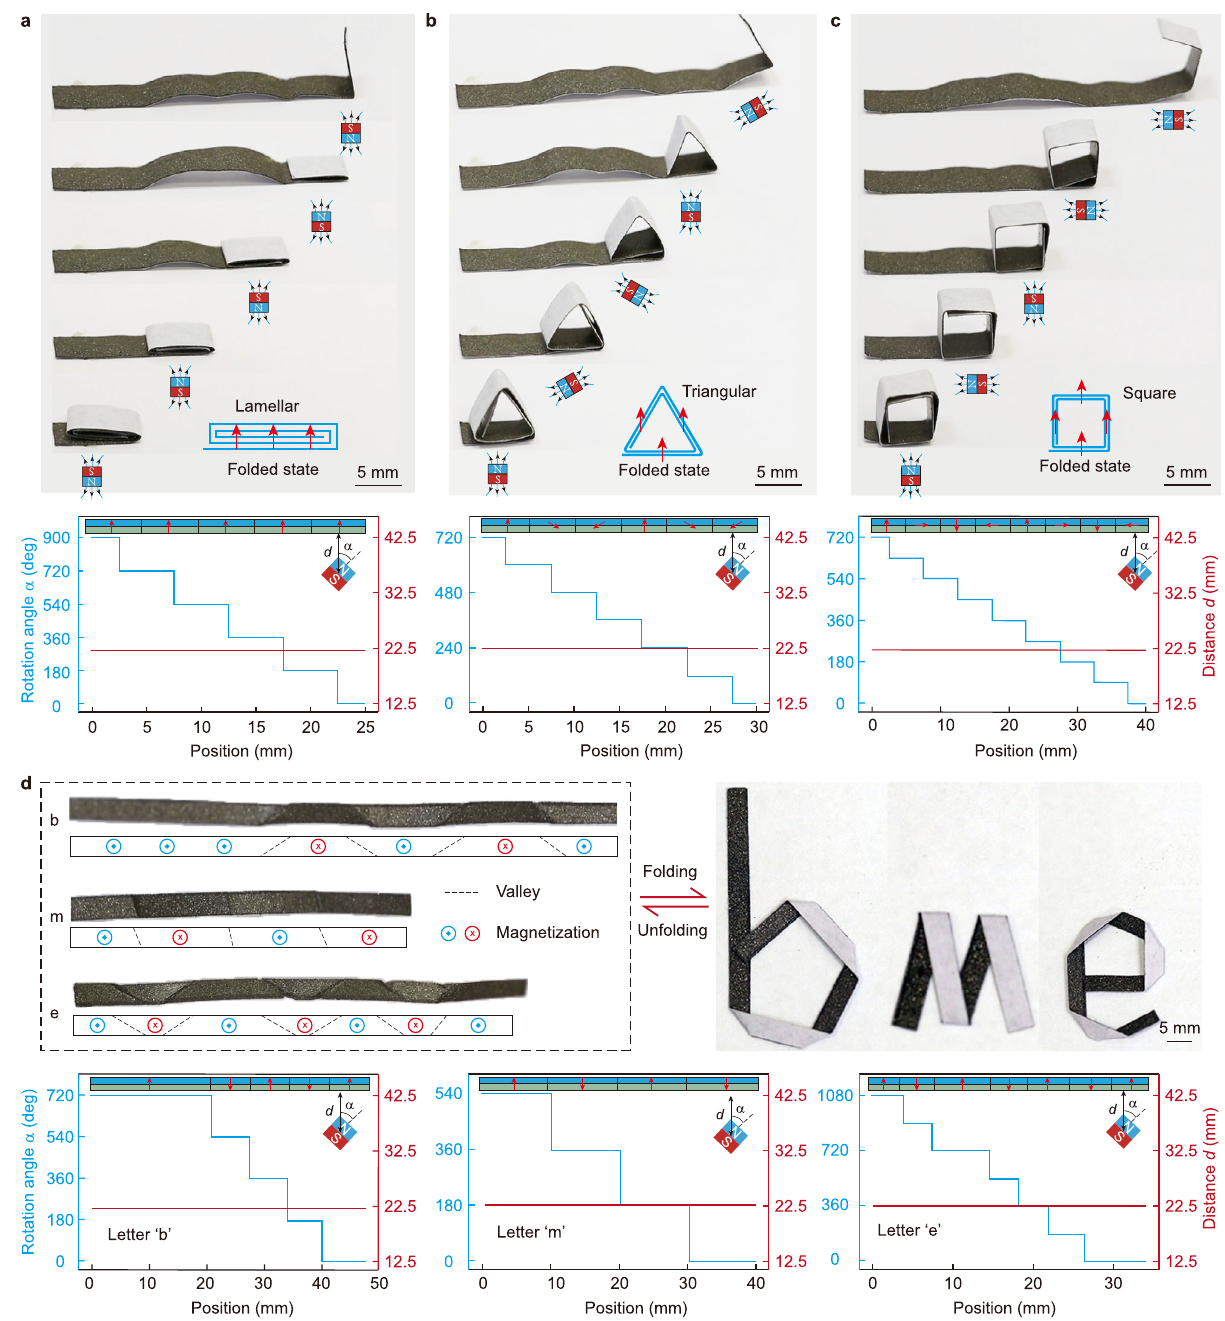
Fig. 4 Sequential folding and unfolding of the magneto-origami strips. a – c The schematic illustrations and experimental demonstrations of magneto- origami strips programmed with alternating magnetic polarity patterns. The magneto-origami strips can be sequentially folded into predesigned 3D shapes: a lamellar, b triangular, and c square, by moving and rotating the permanent magnet. Quantitative control schemes are provided in which rational angle α (left axis, blue curve) and distance d between the magnet and magneto-origami strip is plotted as a function of the magnet position. d Experimental demonstrations and quantitative control schemes of sequential folding of magneto-origami strips into letters “ b ” , “ m ” , and “ e ”